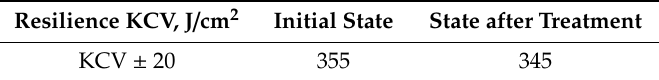
Table 9. Fracture toughness of steel specimens in di ff erent